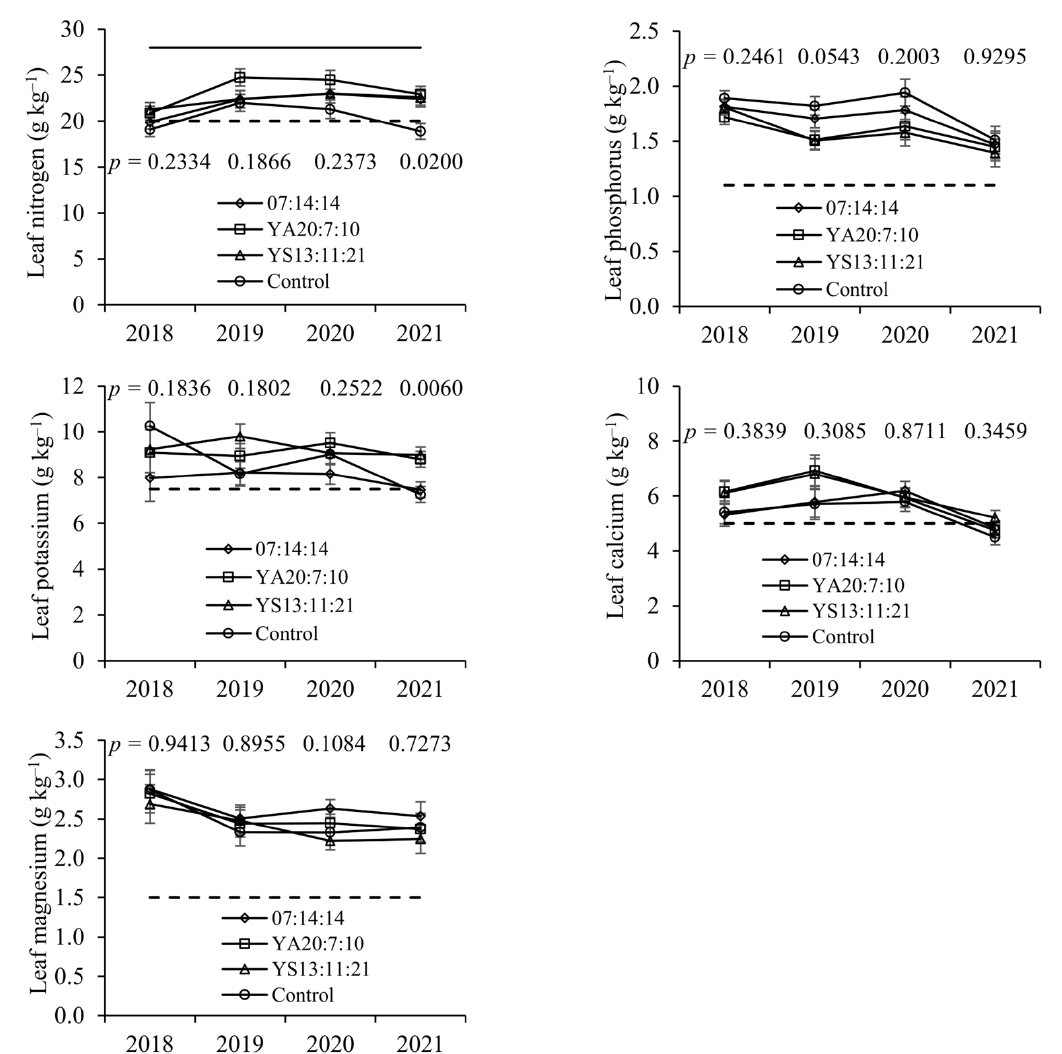
Figure 3. Leaf concentrations of nitrogen, phosphorus, potassium, calcium and magnesium as a response to fertilisation treatments. Dashed and solid lines are, respectively, the lower and upper limits of the sufficiency ranges. Error bars are the standard errors.